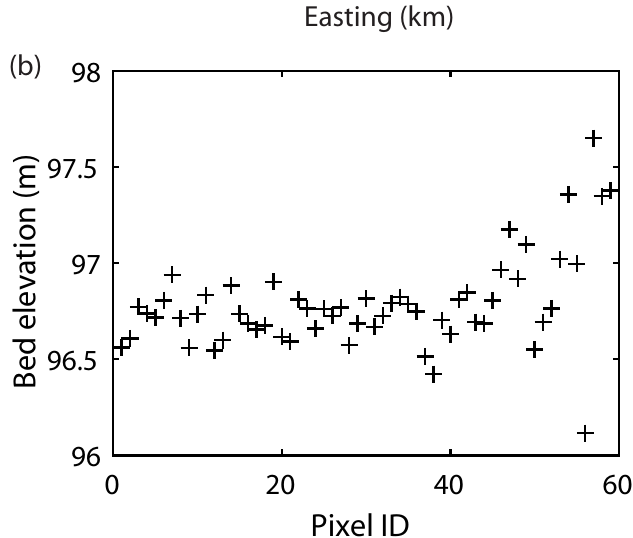
Figure 10. ( a ) Elevations of the riverbed converted from the underwater depths. The elevations are relative to a local reference datum [4]. ( b ) Elevations of the riverbed extracted from ( a ) for 59